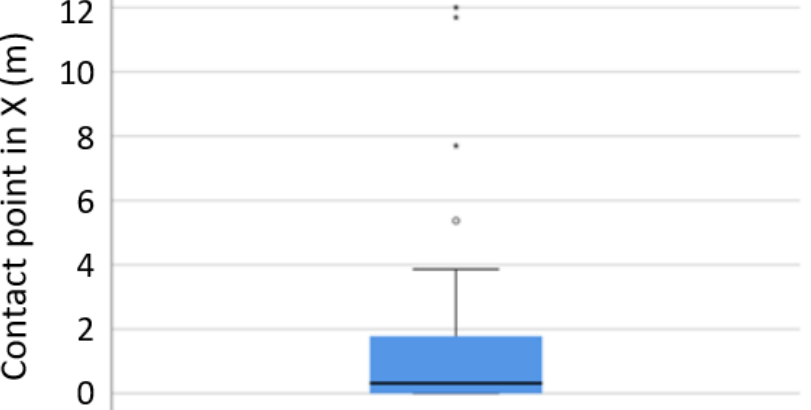
Figure 12. Scenario 2: contact point of cyclist with truck in x-direction from front of truck, based on GIDAS.